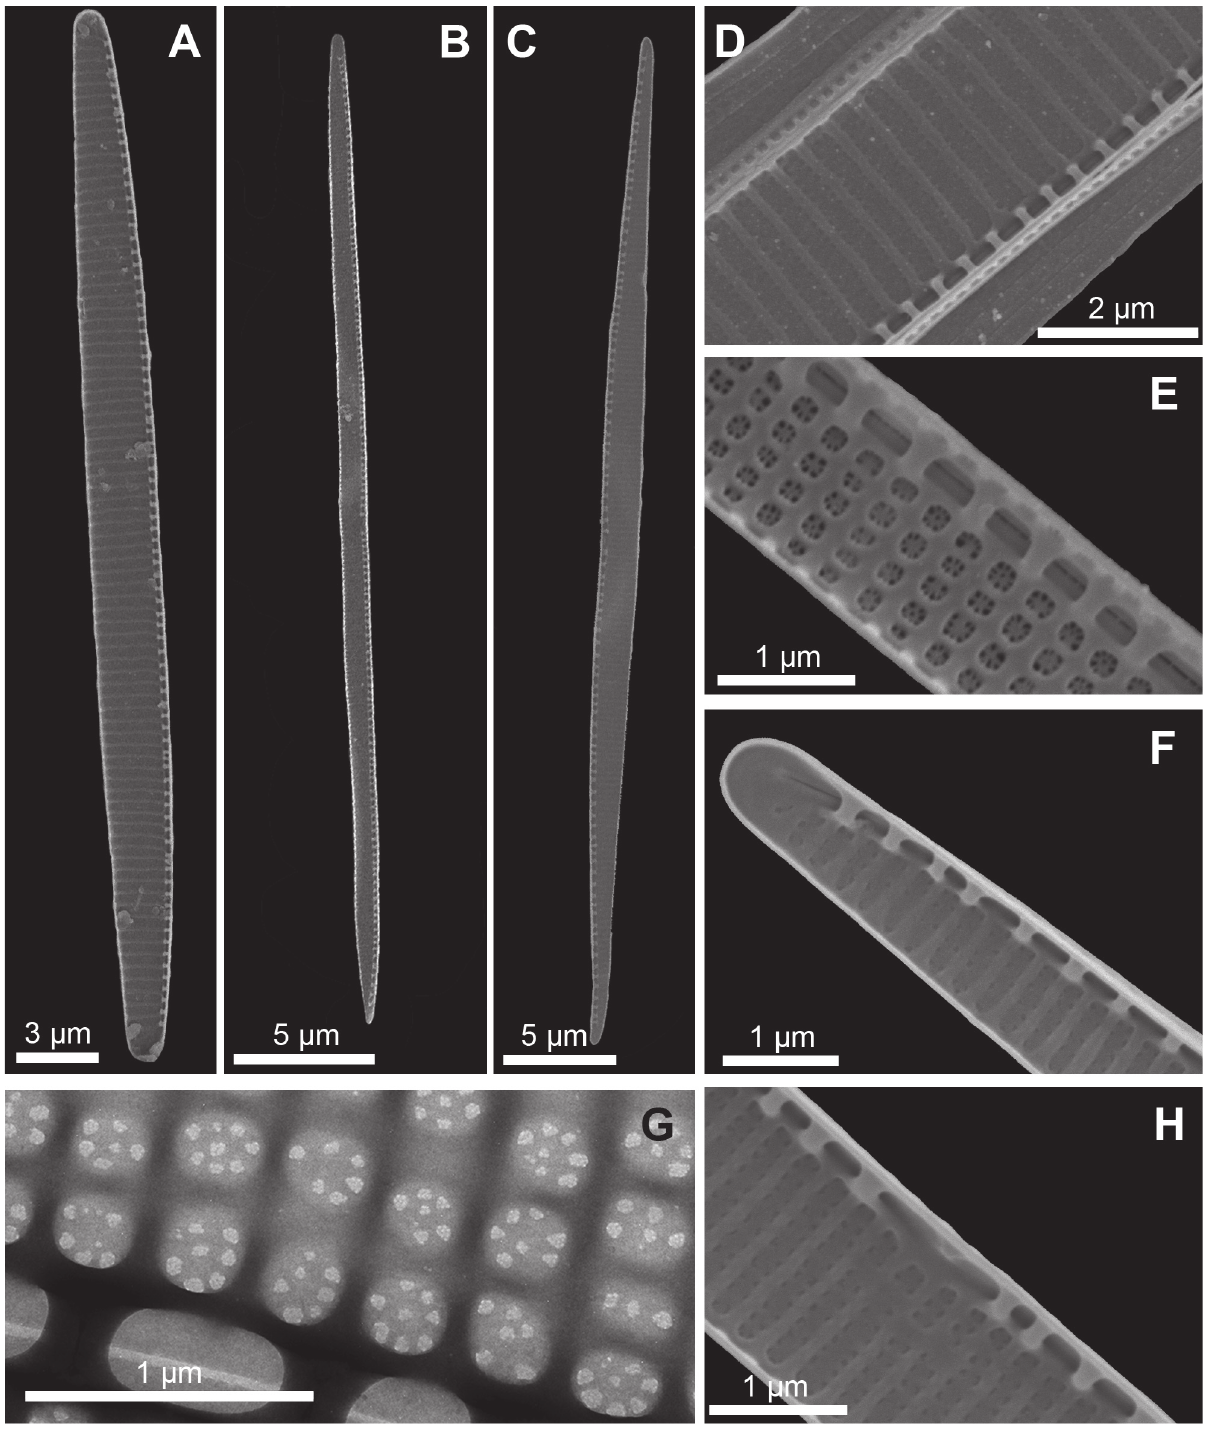
Fig 2. – Sem (scanning electron microscopy) and tem (transmission electron microscopy) of Pseudo-nitzschia species in nW mediterranean Sea. a and d, P. brasiliana (St. 13, 12/09/05); B, e and g, P. calliantha (St. 8, 14/03/05); c, F and h, P. delicatissima (culture icmB-102, St. 22)